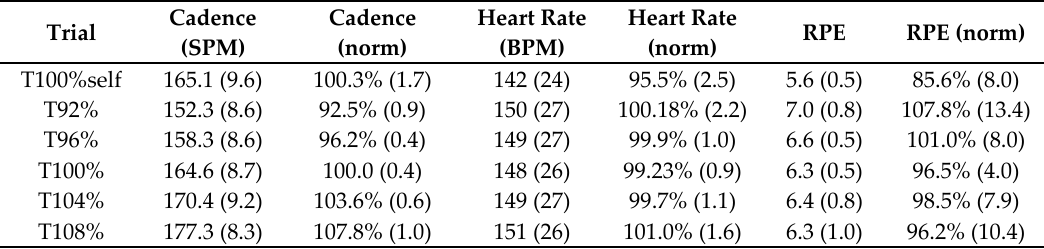
Table 2. Results of the trials including the self-chosen cadence trial. Measured cadence, heart rate, and RPE scores are displayed in absolute values and normalized (norm) values with the standard deviation in between